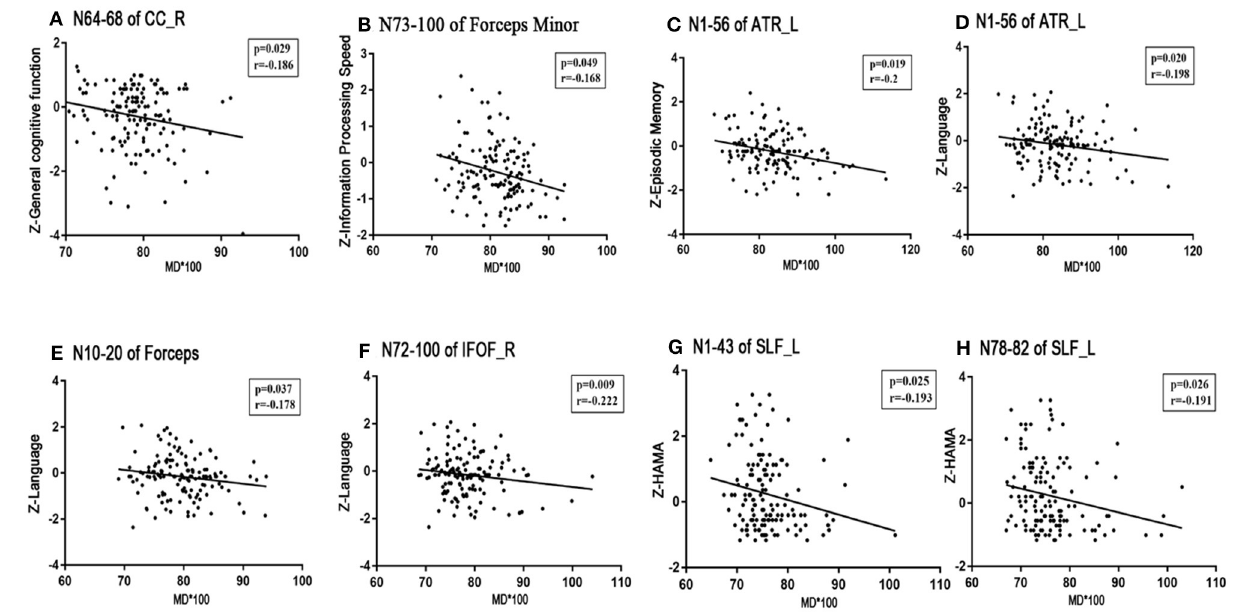
FIGURE 5 | Correlations between MD profiles and neuropsychological examinations. Partial correlation was conducted controlling for age, gender, years of education, history of hypertension, and history of LI/TIA in patients with CSVD. (A) The mean MD value of the posteromedial component of the right CC (nodes 64–68) correlated negatively with general cognitive function ( r = − 0.186, p = 0.029). (B) The mean MD value of the frontal lobe portion of the callosum forceps minor (nodes 73–100) correlated negatively with information processing speed ( r = − 0.168, p = 0.037). (C) Episode memory was negatively associated with the MD value of the anterior half of the left ATR (nodes 1–56, r = − 0.2, p = 0.019). (D–F) Higher MD in the anterior half of the left ATR (nodes 1–56, r = − 0.198, p = 0.020), frontal lobe portion of the callosum forceps minor (nodes 10–20, r = − 0.178, p = 0.037), and anterior component of the right IFOF (nodes 72–100, r = − 0.222, p = 0.009) showed significant impairment in the language domain. (G,H) HAMA was negatively related to the MD values of the anterior and posterior portion of left SLF (nodes 1–43, r = − 0.195, p = 0.025; nodes 78–82, r = − 0.191, p = 0.026). CSVD, cerebral small vessel disease; LI, lacunar infarction; TIA, transient ischemic attack; WMH,